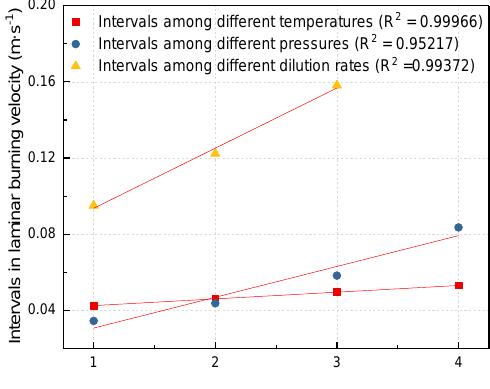
Figure 7. Fitting of the interval values.